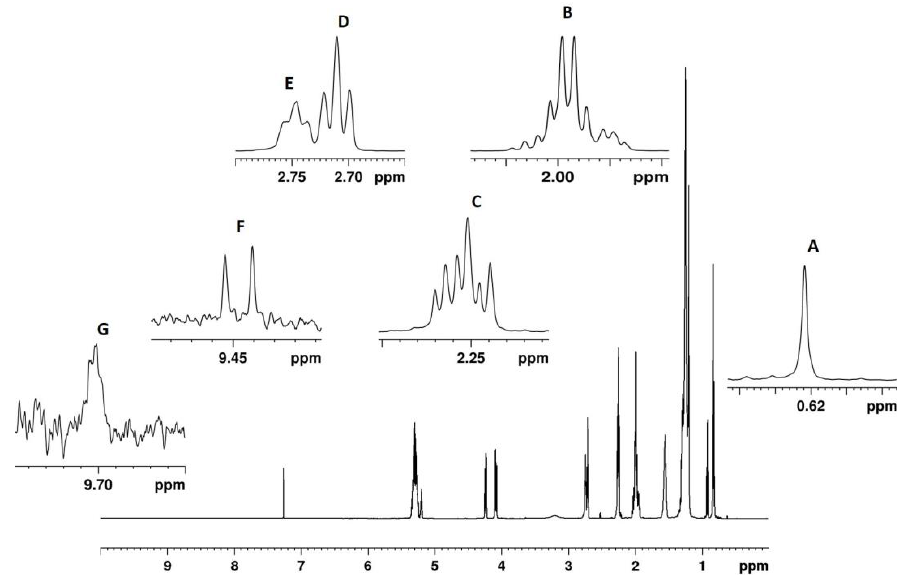
Figure 2. 600.13 MHz 1 H NMR spectrum of a hemp seed oil. Quantified selected NMR signals are reported in expanded regions. ( A ) β-sitosterol (0.622 ppm); ( B ): allylic protons of all fatty chains